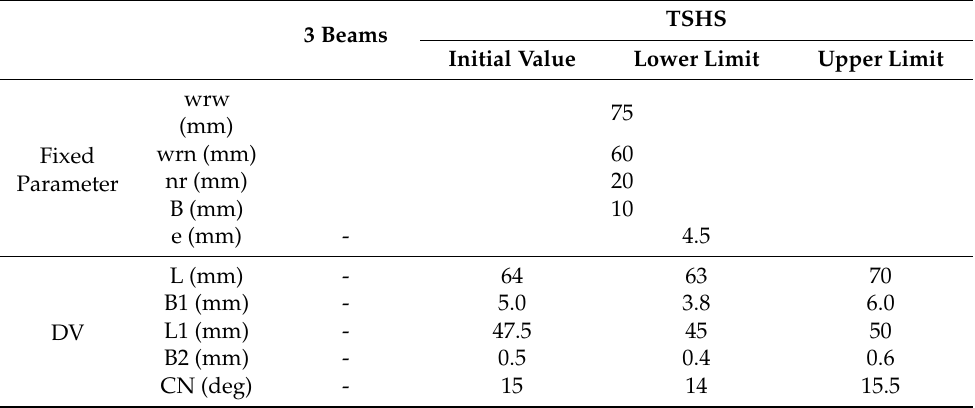
Table 2. The optimal design and FEA results of TSHS.